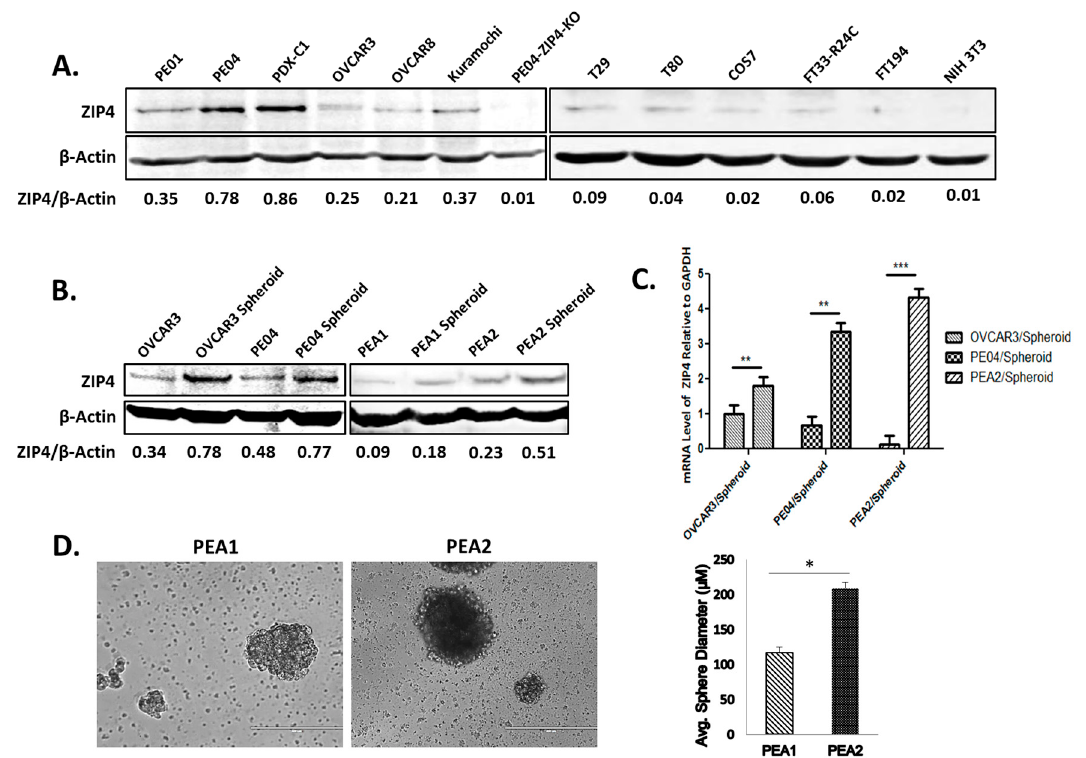
Figure 1. Increased protein and mRNA expression of ZIP4 in high grade serous ovarian cancer (HGSOC) cells, spheroids vs. non-malignant cells and ZIP4 + cell isolation. ( A ) Left panel: Western blot analysis of ZIP4 expression in HGSOC cell lines PE01, PE04, a HGSOC PDX cell line PDX-C1, OVCAR3, OVCAR8, Kuramochi, and PE04-ZIP4-KO (this ZIP4-knockout cell line is described in our previous publication [14]). The relative expression levels were quantified using the ratios of ZIP4 / β -actin. Right panel: Western blot analysis of ZIP4 expression in non-tumorigenic cell lines T29, T80, COS7, FT33-R24C, FT194, and NIH3T3. ( B ) In OVCAR3, PE04, PEA1, and PEA2, ZIP4 expressed at higher levels in spheroid cells (3D) than in non-spheroid cells (2D). Same numbers of cells (5000 / well into 6-well plates) were initially seeded for 3D (Costar ® 6-well Ultra-Low Attachment Plates) and 2D cultures. We collected cells after 3 and 14 days for the 2D and 3D culture, respectively. The ratios of ZIP4 / β -actin were used for the quantitative comparisons. The uncropped Western blot images for (A) and (B) are shown in the Figure S2. ( C ) Human ZIP4 mRNA expression in HGSOC cell lines cultured in regular medium with FBS vs. 3D conditions to form spheroids. In OVCAR3, PE04, and PEA2, ZIP4 expressed at higher levels in spheroid cells (3D) than in non-spheroid cells (2D) (scale bar = 400 µ m). The results were from three independent experiments. ** p < 0.01, *** p < 0.001. ( D ) Spheroids that developed from PEA2 cells are larger than those from PEA1 cells. The bars in the graph depict the average ± SD of spheroids formed in three independent experiments. * p <